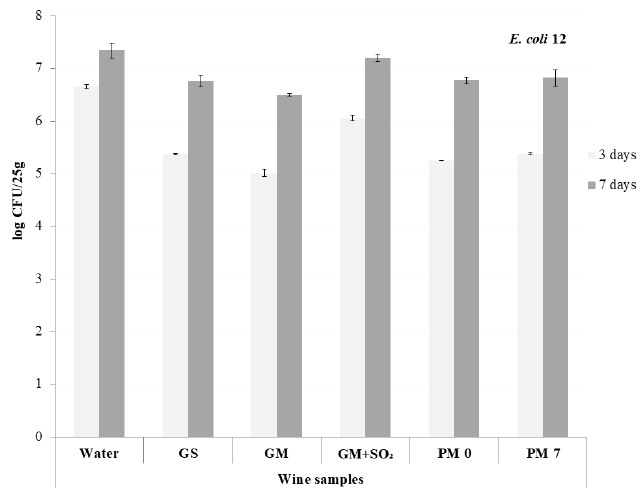
Figure 2. Count of E. coli (WDCM00012) in wine-marinated seabass ( Dicentrarchus labrax ); (GS— standard white wine, GM and GM + SO 2 —macetared white wine with and without SO 2 , PM 0—rosé, PM 7—macerated redwine) after 3 and 7 days of storage at 4 ± 1 °C.